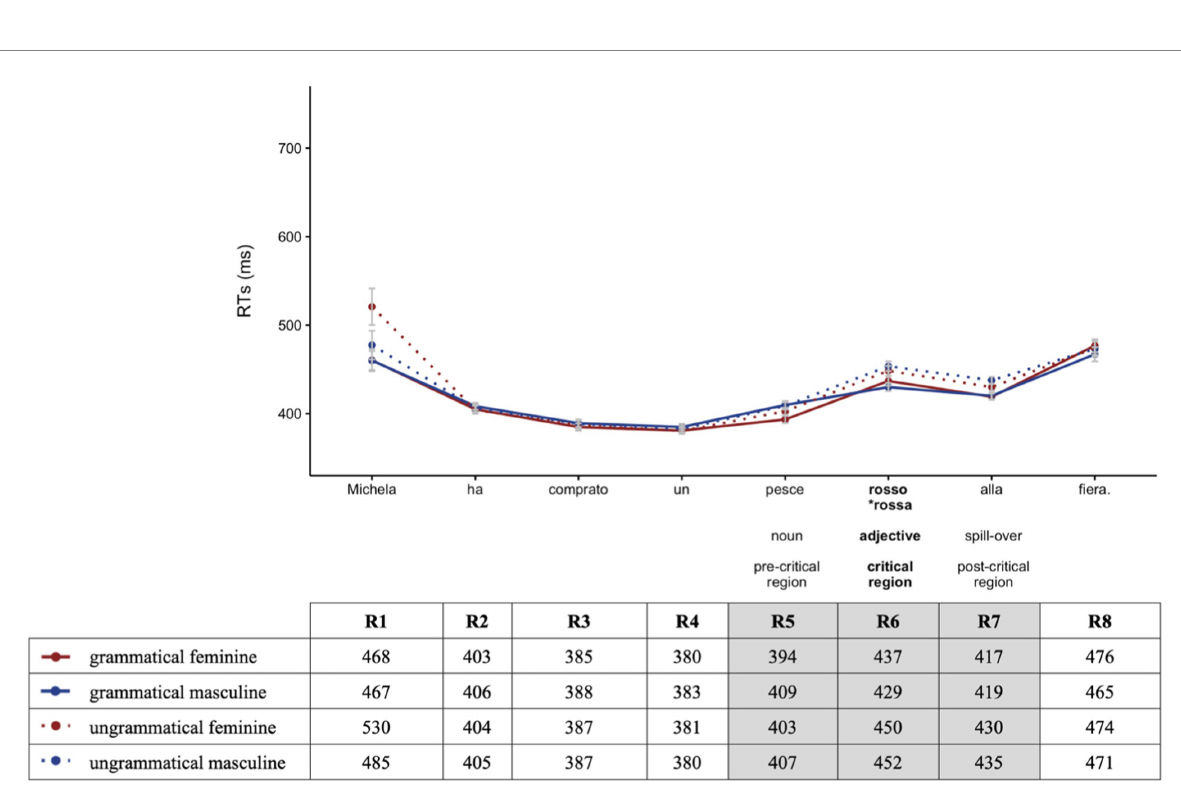
FIGURE 3 Homeland speakers’ mean RTs by region for grammatical (solid lines) vs. ungrammatical (dotted lines) sentences for feminine (red) and masculine